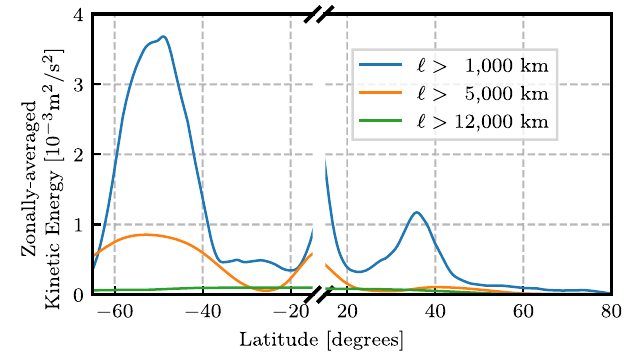
Fig. 5 | Energy by latitude. Time- and zonally-averaged kinetic energy computed fromAVISOasafunctionoflatitudeforaselectionof fi lterscales(seelegend).Note that the latitude axis is broken to exclude the band [15°S,